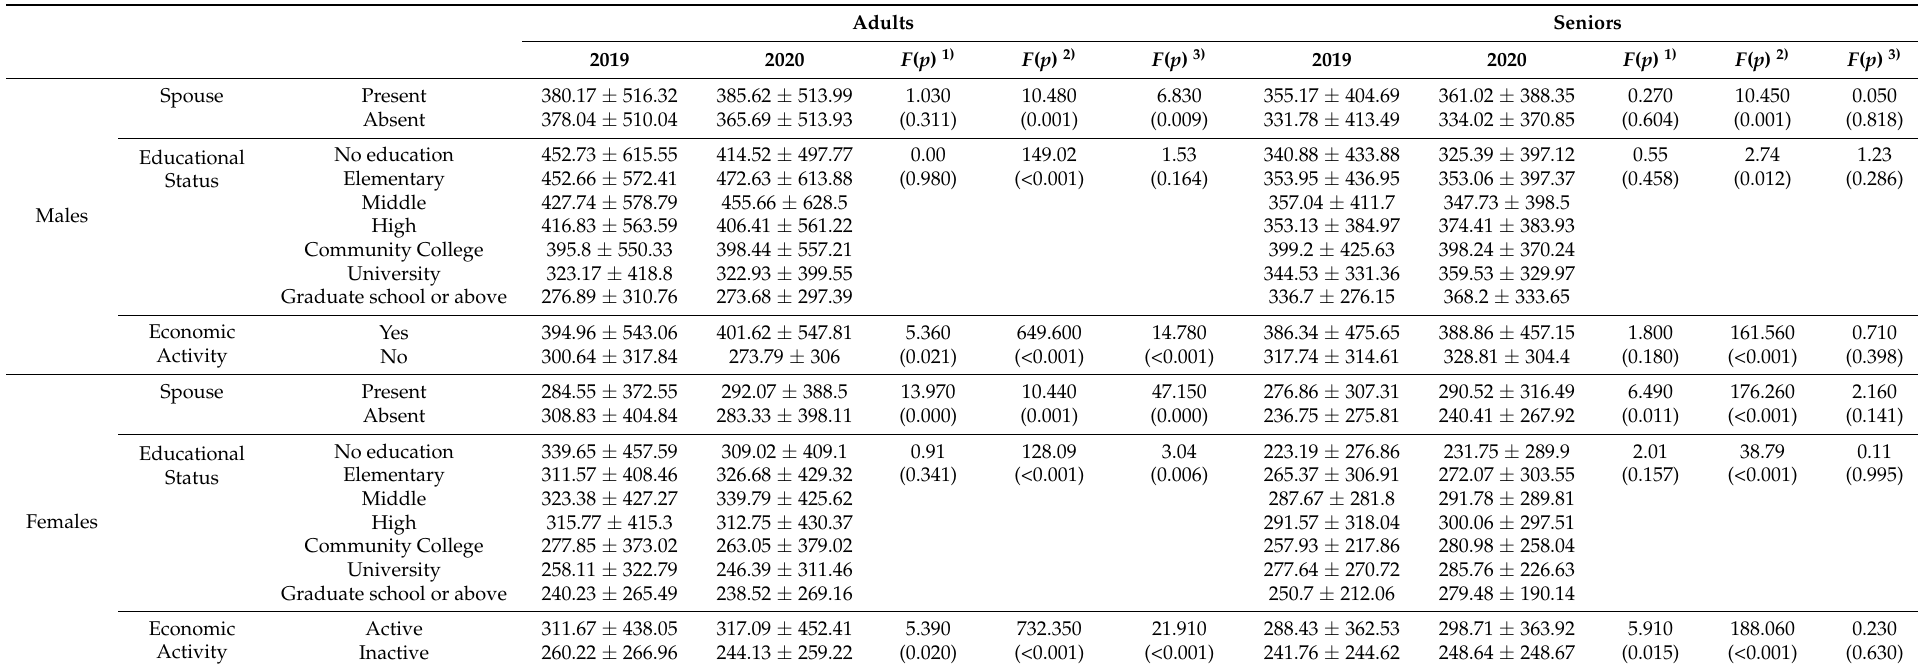
Table 4. Differences in physical activity (walking) by general characteristics of subjects (2019–2020). Adults